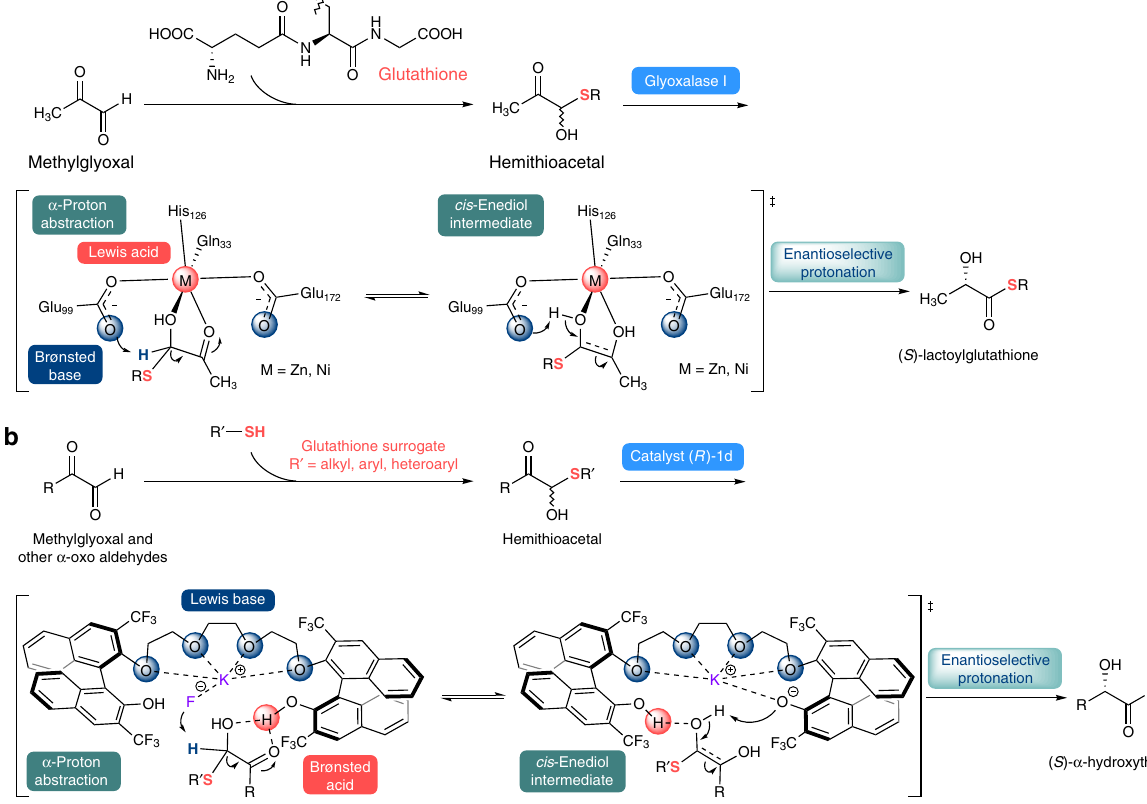
Figure 1 | Glyoxalase I pathway and glyoxalase I-mimic reaction design. ( a ) Detoxification of methylglyoxal via enantioselective isomerization catalysed by glyoxalase I. M ¼ Zn for the eukaryotic glyoxalase I such as human and yeast; M ¼ Ni for the prokaryotic glyoxalase I such as the bacteria Escherichia coli and Pseudomonas aeruginosa . ( b ) Plausible working hypothesis for the enantioselective isomerization of hemithioacetals catalysed by artificial glyoxalase